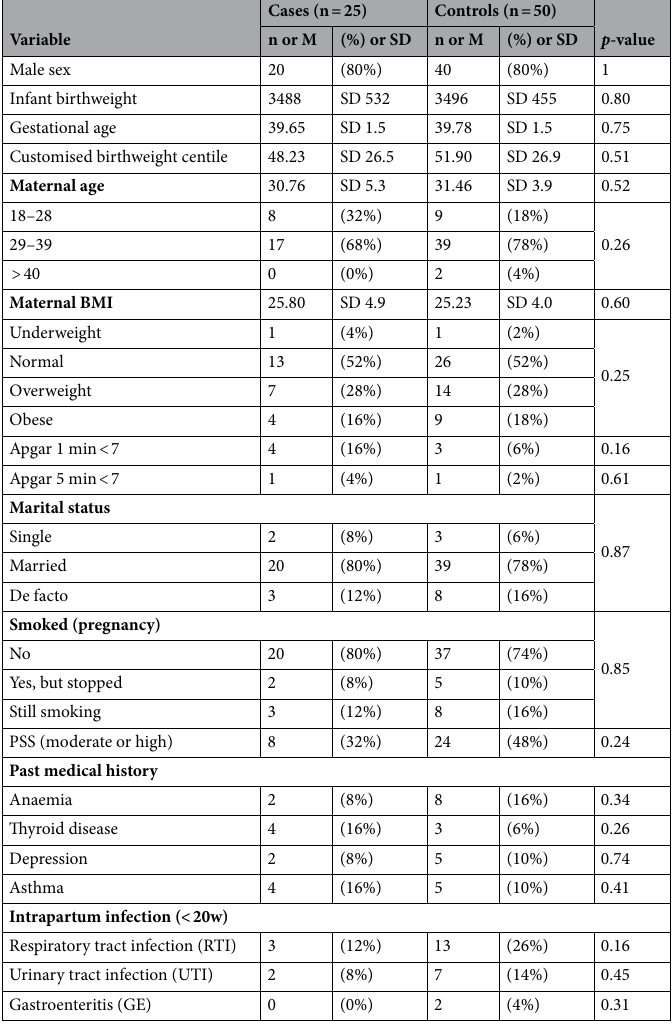
MSD multiplex V‑plex. In Fig. 2 IFNγ concentration in ASD cases versus matched controls Fig. 2, IFNγ concentration was analysed using the Mesoscale Discovery platform. Units of concentration are pictograms/ millilitre (pg/ml). IFNγ was not significantly altered in mothers of ASD affected children (median 2.773) at 20 weeks’ gestation compared to neuro-typical controls (median 2.763). ROUT analysis (Q = 1%) was performed to identify and exclude outliers. In total, five outliers were removed (three controls and two cases). Final analysis was performed on n = 22 cases and n = 37 controls p = 0.99.